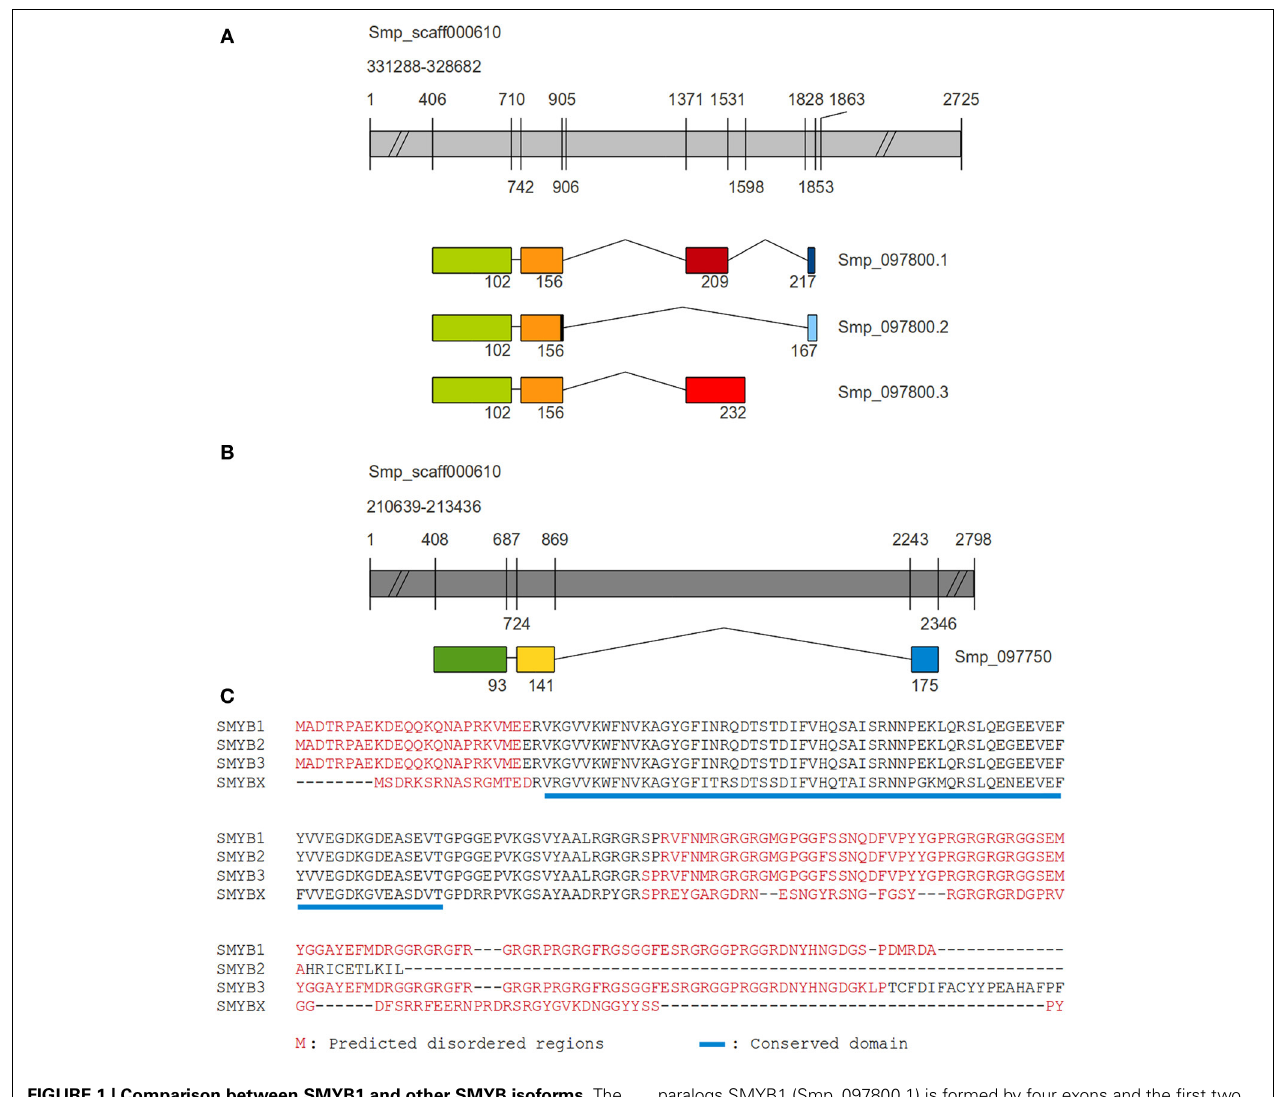
paralogs SMYB1 (Smp_097800.1) is formed by four exons and the first two (green and orange boxes) are shared with isoforms SMYB2 (Smp_097800.2, with one extra nucleotide at the end of the second exon) and SMYB3 (Smp_097800.3). While the SMYB2 isoform contains an exon (light blue box) similar to SMYB1 exon 4 (navy blue box), but longer (and in a different reading frame), SMYB3 contains a third exon (light red) which is similar to SMYB1 exon 3 (dark red), but longer. (C) Muscle alignment of SMYB1 (Q27277), SMYB2 (G4LXD2), SMYB3 (G4LXD0), and the SMYBX_putative (G4LXC4). Disordered regions are highlighted in red, according to Disopred predictions and the conserved domain is underlined in